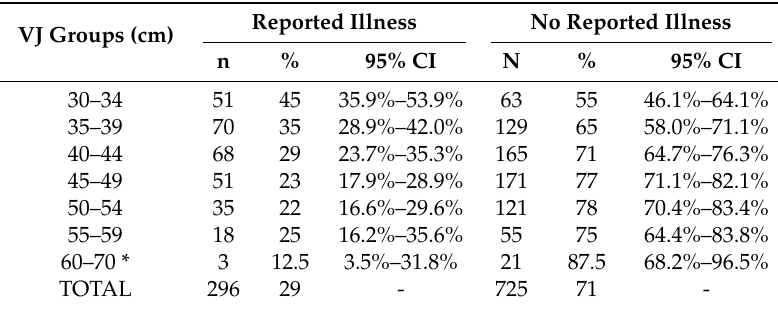
Table 2. Vertical jump score comparison for trainees diagnosed with an illness versus those not reporting or diagnosed with an illness.